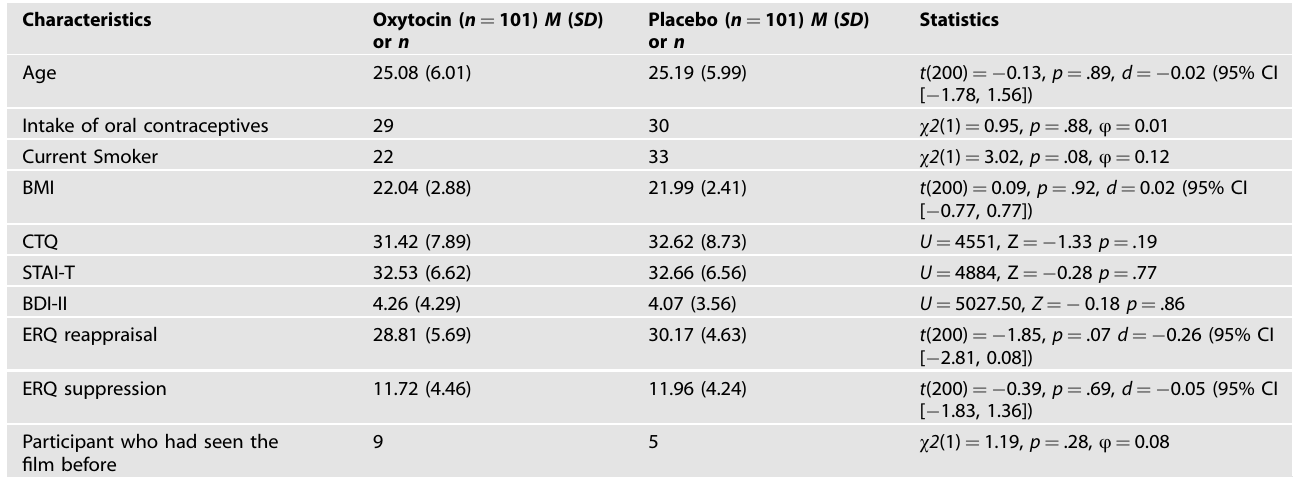
Table 1. Sample characteristics.